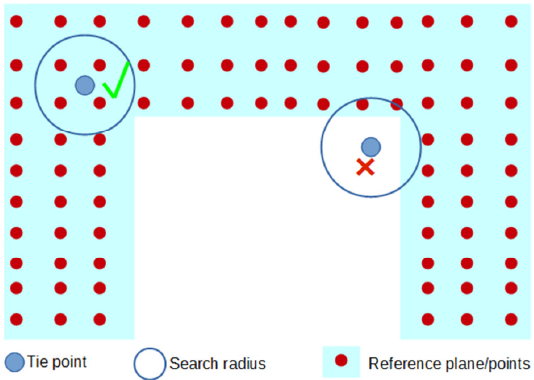
Figure 9. Filtering of tie points: only those which are surrounded by reference points are selected. For all tie points assigned to one reference plane, the following values/statistics are computed. A schematic representation of these measures is shown in Fig. 10: (i) the absolute and signed distance to the plane of each tie point (dN). (ii) the mean absolute and signed orthogonal distance to tie points, including standard deviation of tie points from the corresponding reference plane. (iii) the mean absolute horizontal and signed vertical component (dZ) of the offset (for horizonal planes only the vertical component, and for vertical planes only the horizontal offset) of tie points from the corresponding reference plane.